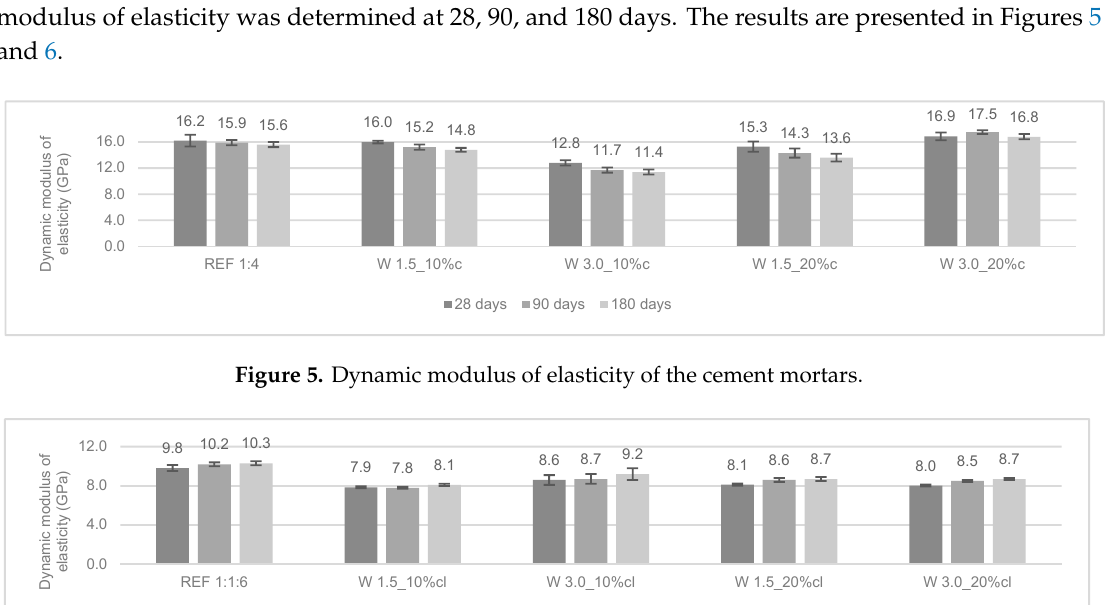
Figure 4. Dry bulk density of the hardened mortars.